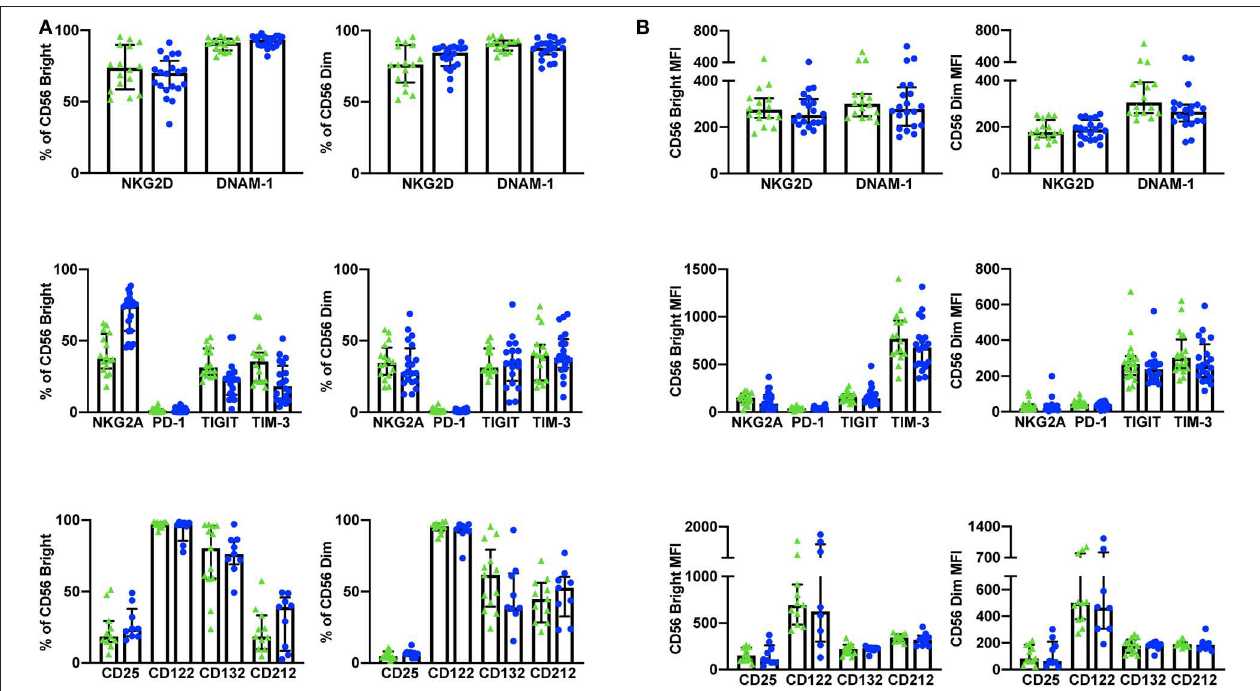
FIGURE 2 | Whole blood extracellular surface receptor expression. The percentage of CD56 Bright / Dim CD3 − cells expressing activating receptors (NKG2D and DNAM-1), inhibitory receptors (NKG2A, PD-1, TIGIT, and TIM-3), and cytokine receptor subunits (CD25, CD122, CD132, and CD212) was assessed in healthy donors ( n = 29) and cancer patients ( n = 31) (A) . The relative level of expression (MFI) of the same activating/inhibitory/cytokine receptors was also assessed in CD56 Bright / Dim CD3 − cells (B) . Shown are the median values ± IQR.